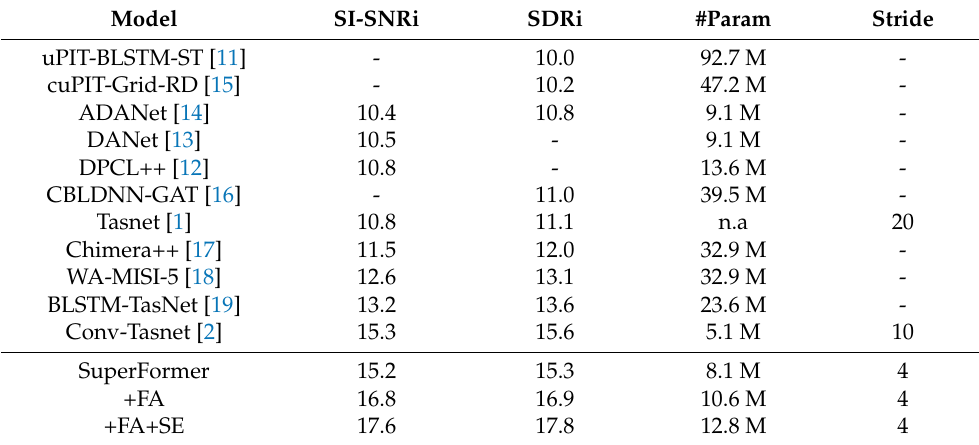
Table 1. Comparison with other methods on the WSJ0-2mix